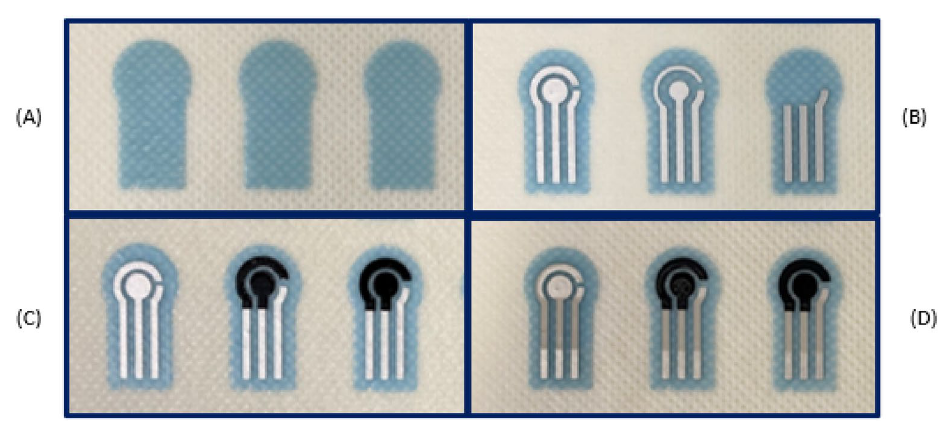
Figure 4. Different stages of screen printed electrodes ( A ) interface layer, ( B ) Silver, ( C ) Carbon, ( D )